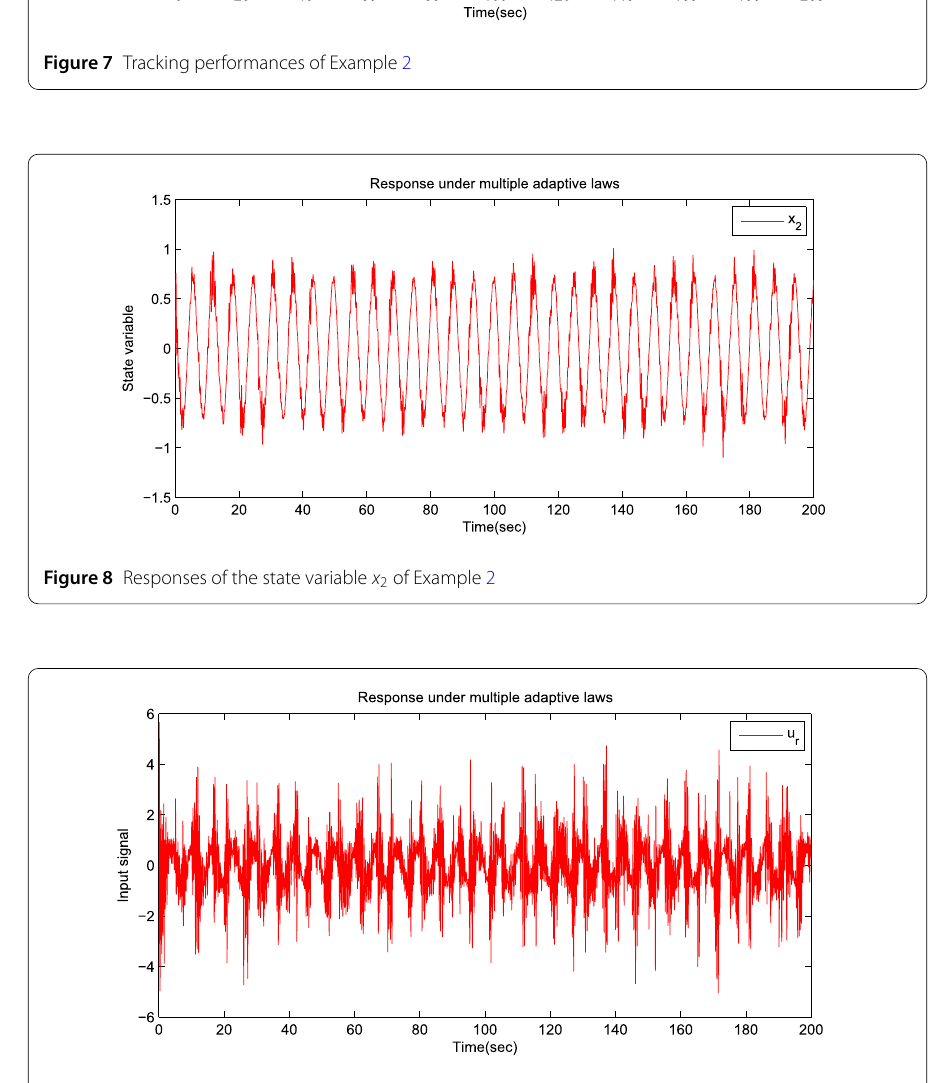
Figure 9 Responses of the control input signal of Example 2